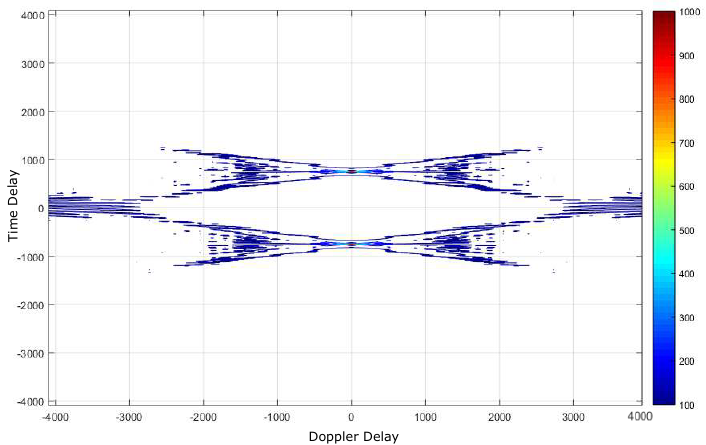
Figure 21. Two closer scatterers using chirp pulses (MMPP): 2D, with no noise.